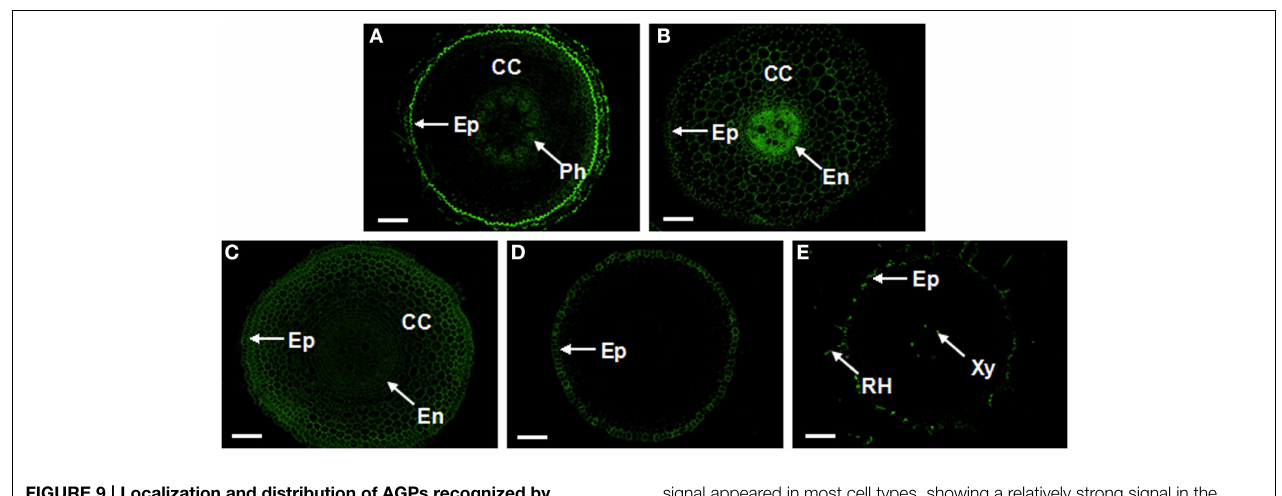
FIGURE 9 | Localization and distribution of AGPs recognized by JIM16, LM2, LM14, and JIM13 antibodies in cross-sections from banana ( Musa spp. AAA) roots. (A) The JIM16 epitopes present in the outer part of epidermis, cortical cells adjacent to the epidermis and in phloem cells; (B) The strongest signal of LM2 in the central cylinder enclosed by the endodermis, followed by cortical cells and the epidermis; (C) The LM14